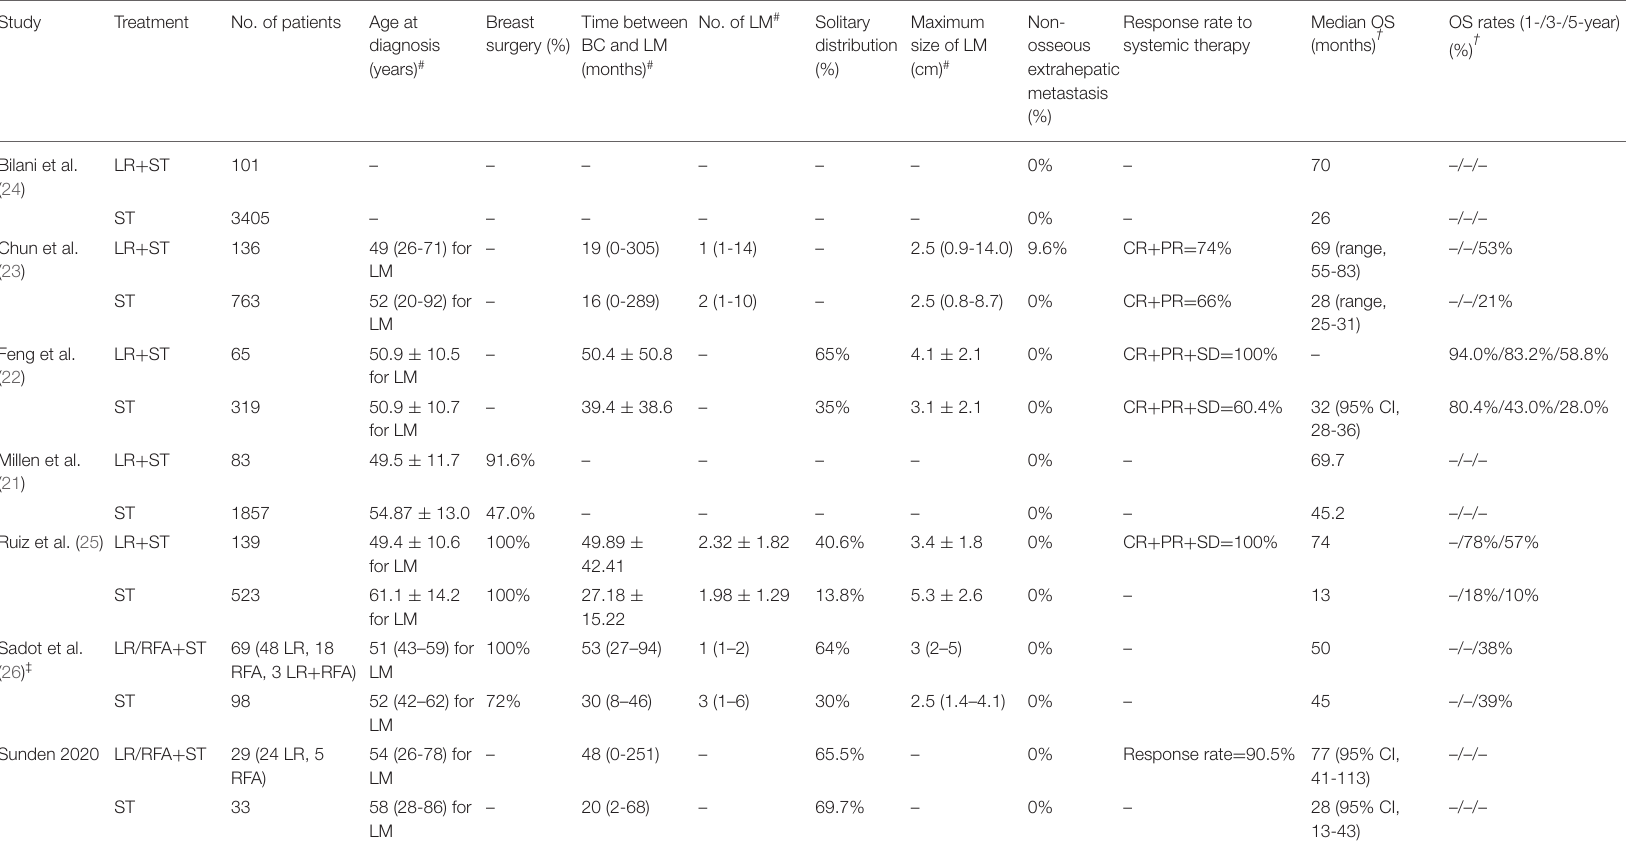
TABLE 2 | Characteristics of patients with breast cancer liver metastases in the unmatched cohorts (before matching or in studies without matching).